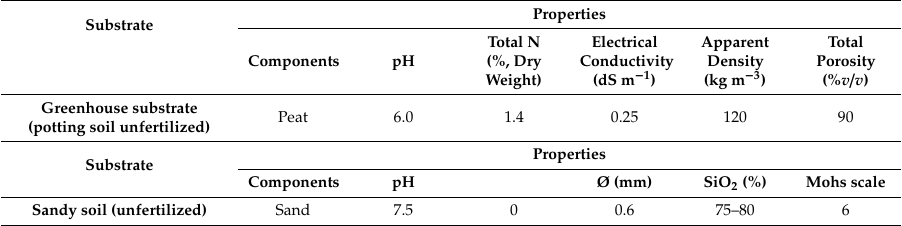
Table 3. Chemico-physical characteristics of the